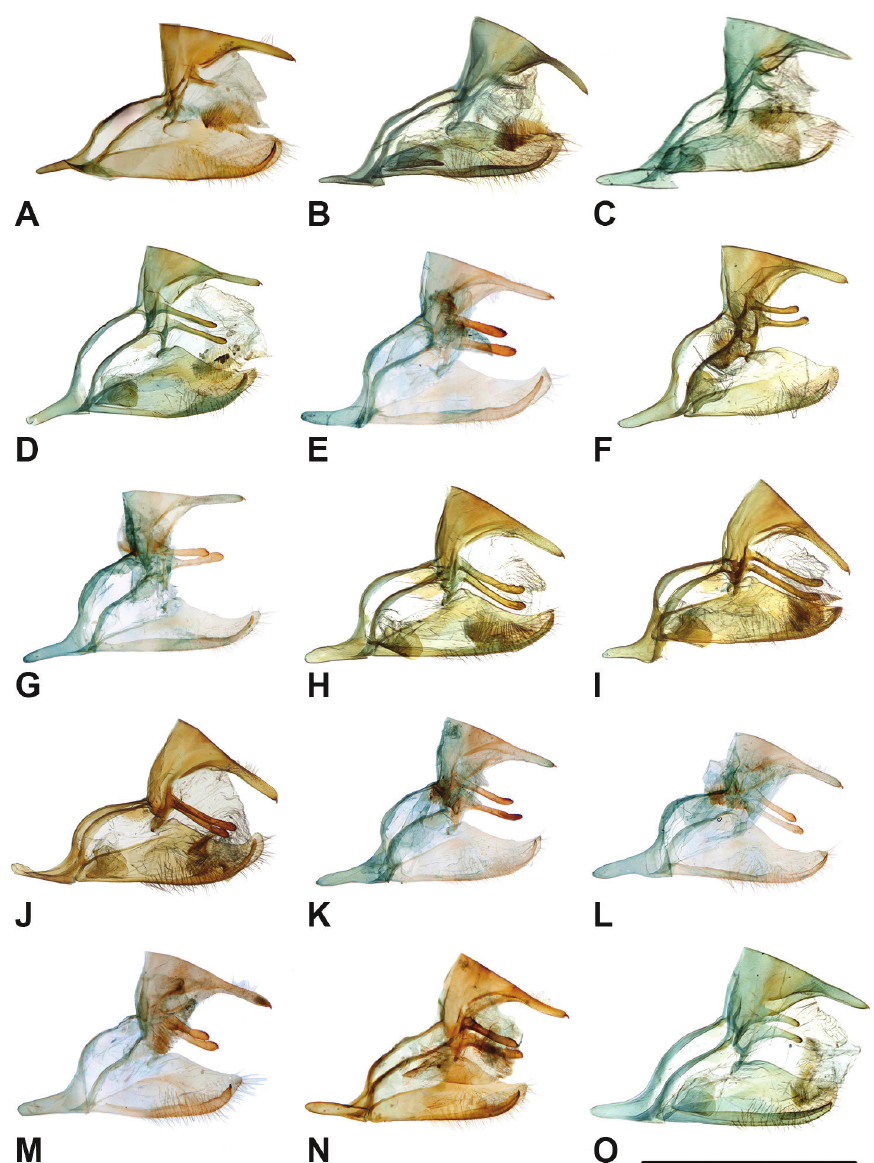
Figure 24. A panthera balina MCZ Indonesia: Bali B obnubila NHM Peninsular Malaysia: